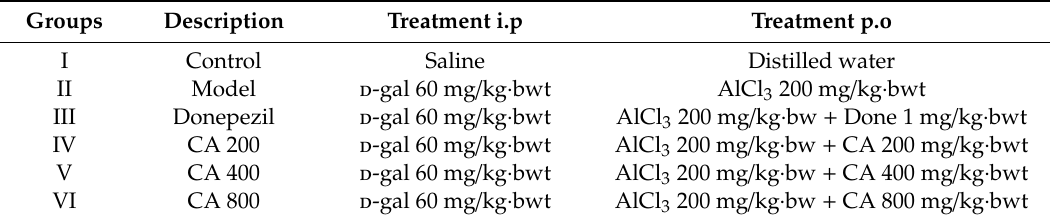
Table 1. AlCl 3 , d -gal, donepezil and CA treated groups and the control.